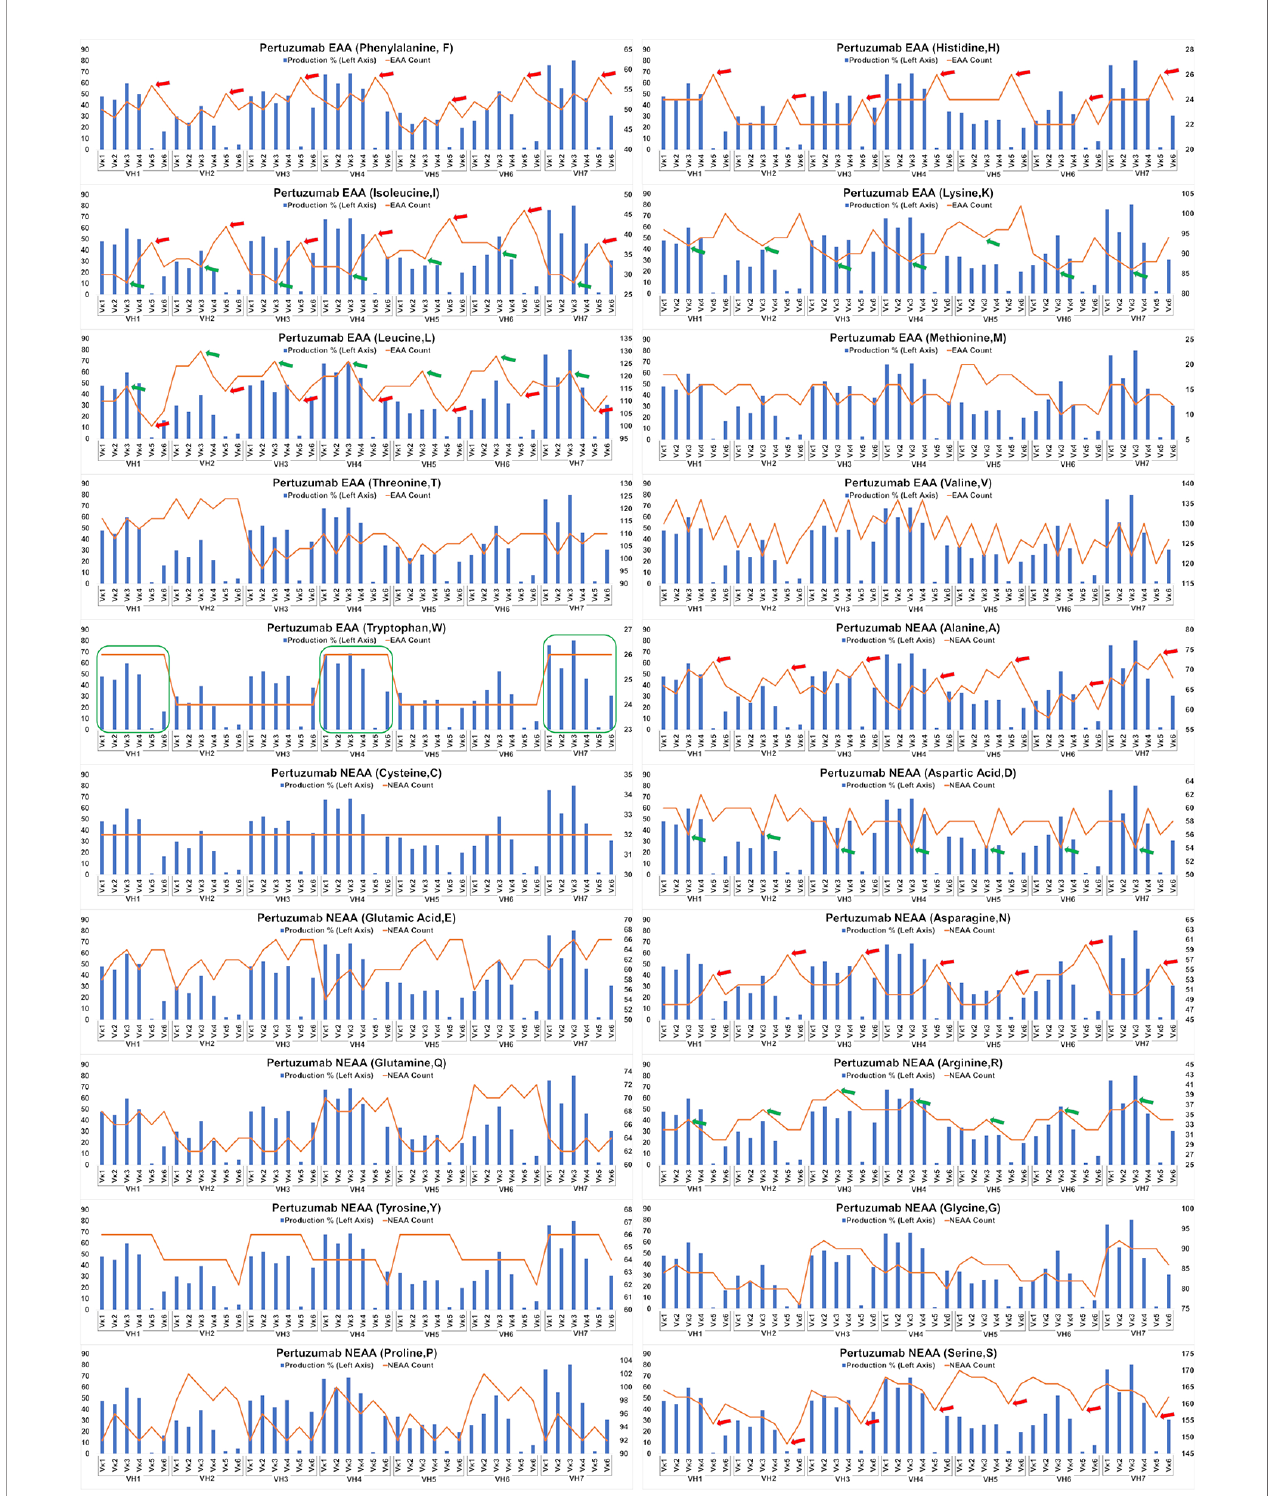
FIGURE 5 | Production in % (in bars, left axis) and amino acid counts (line, right axis) charts of recombinant Pertuzumab variants. The green arrows/boxes refer to an increase in production level while the red arrows depict a decrease in production